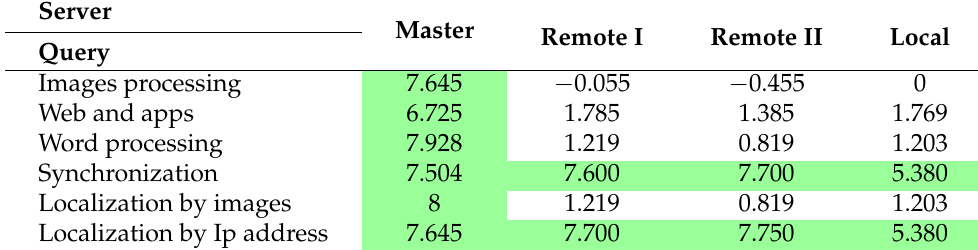
Table 15. Saaq score values for Scenarios O1 and O2.